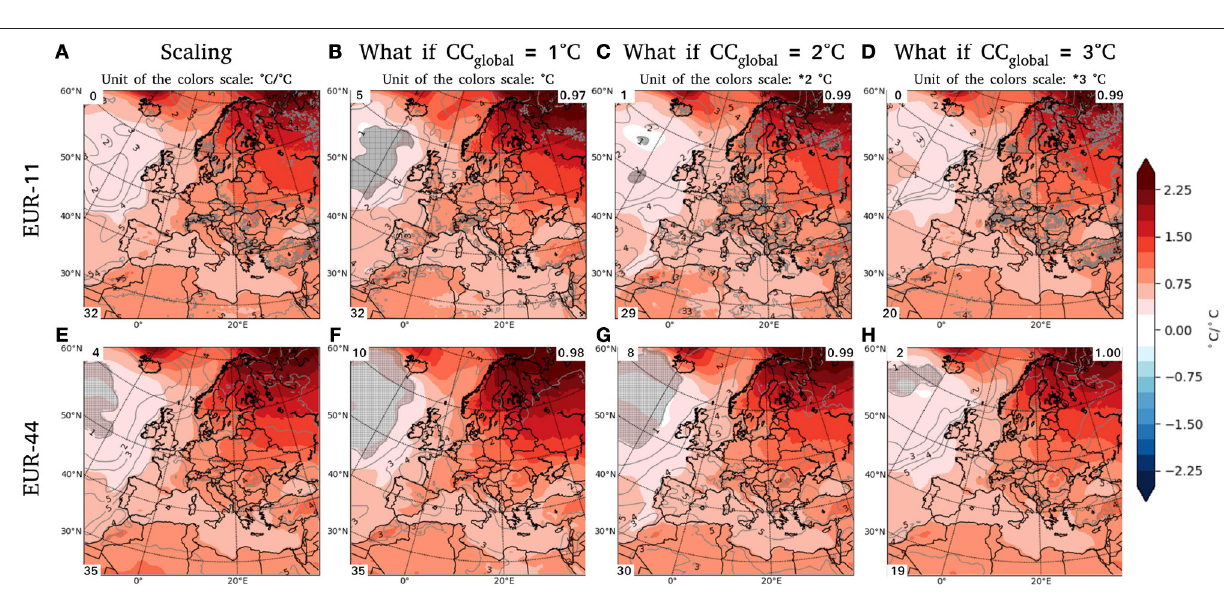
FIGURE 10 | DJF temperature. Specifications and conventions as in Figure 8